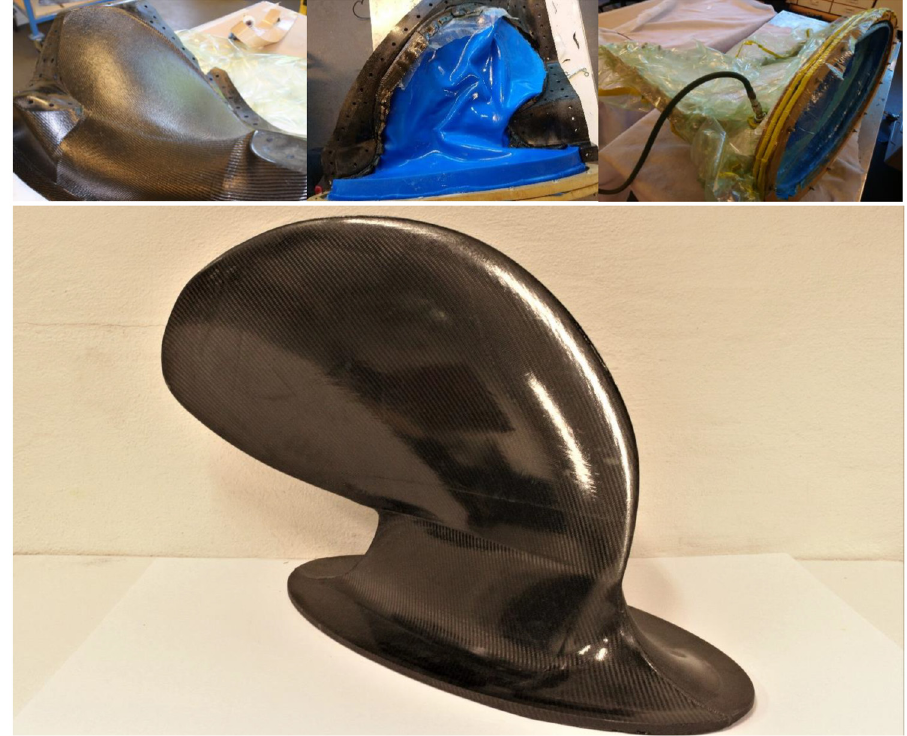
Figure 8. CFRP layup on a mould half, mould half with layup and silicone bladder, the assembled mould before oven curing cycle and the finished cast after demolding. Photos from